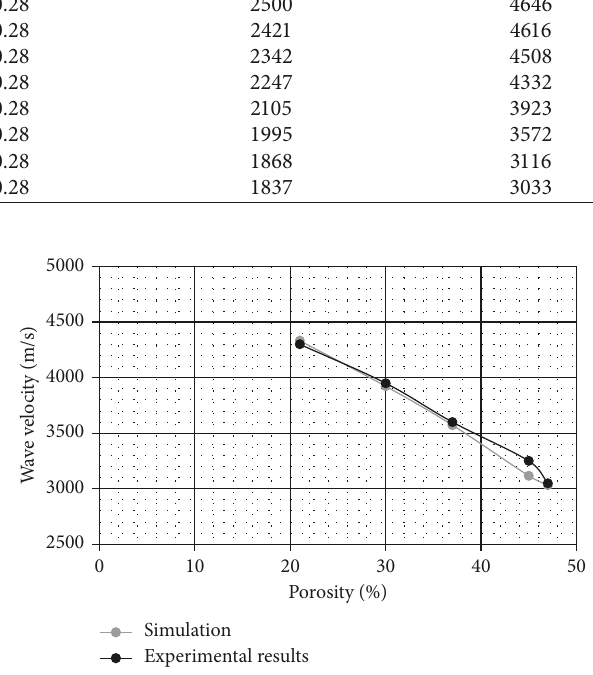
Figure 4: Comparison of back-calculated wave velocity of fully dry cement paste with those measured (experimental results of Maalej et al. [19]).